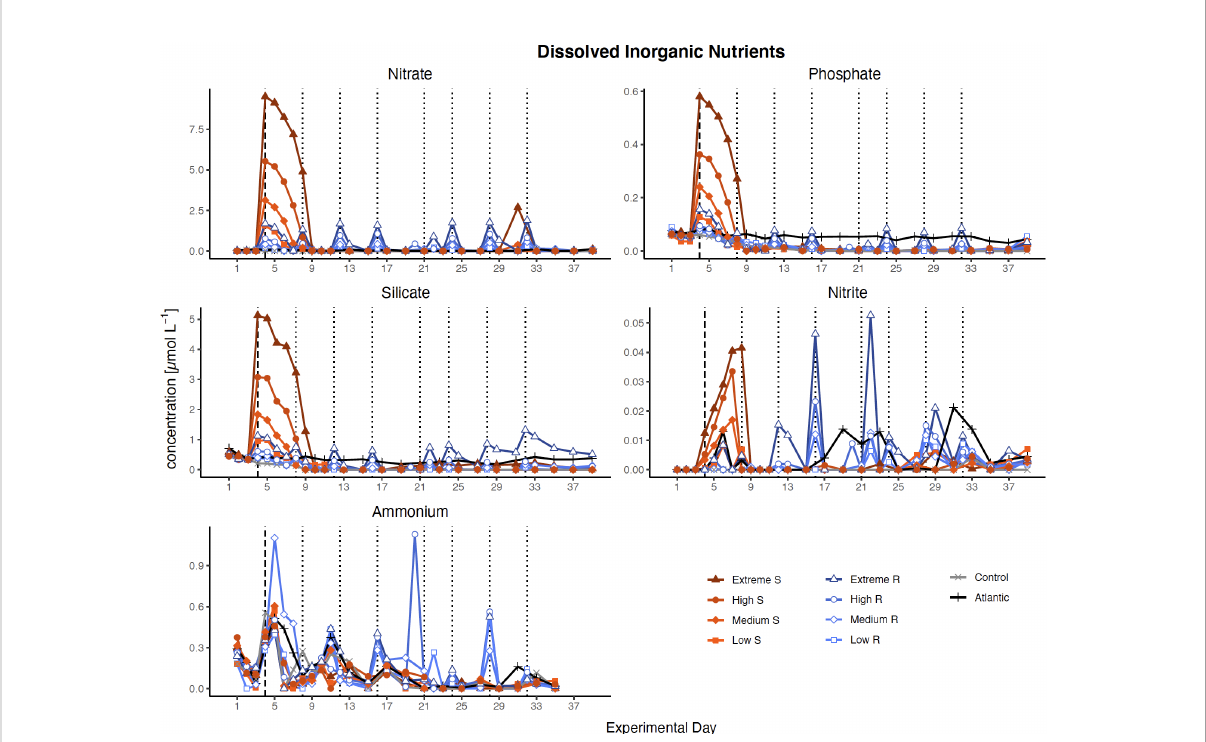
FIGURE 3 Inorganic nutrient concentration over the course of the study. Dotted lines represent DW additions, dashed line marks the single DW addition to singular treatments. S, singular; R,. recurring treatment. Atlantic refers to samples taken from the water surrounding the mesocosm fi